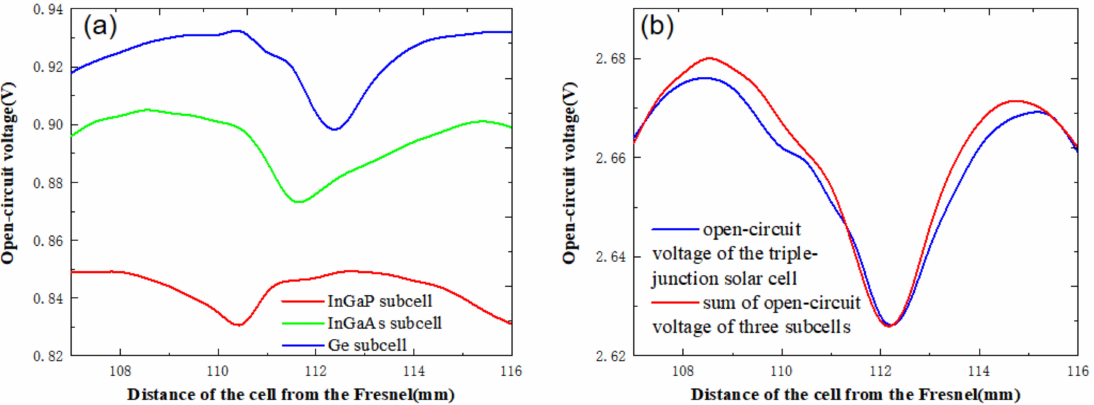
Figure 10. ( a ) Open-circuit voltage of three sub cells; ( b ) Open-circuit voltage of sub cells and open-circuit voltage of triple-junction solar